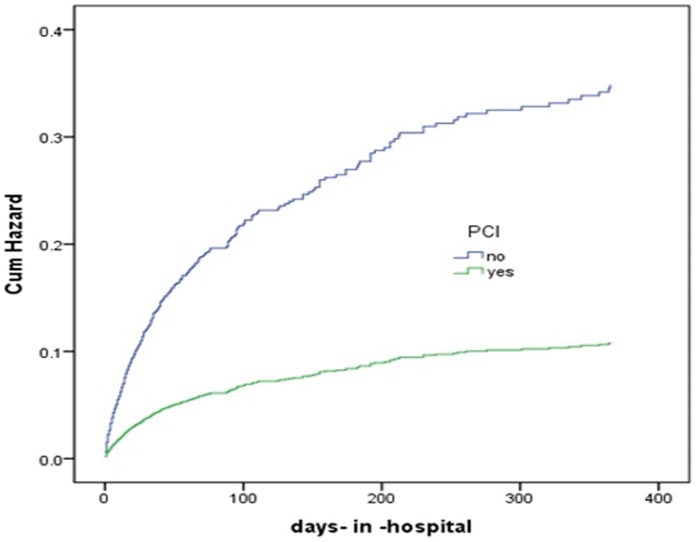
Predicted cumulative hazard function of 1 year mortality for different therapies.The curves were constructed according to the PCI or conservative therapy with the use of Cox regression analysis.